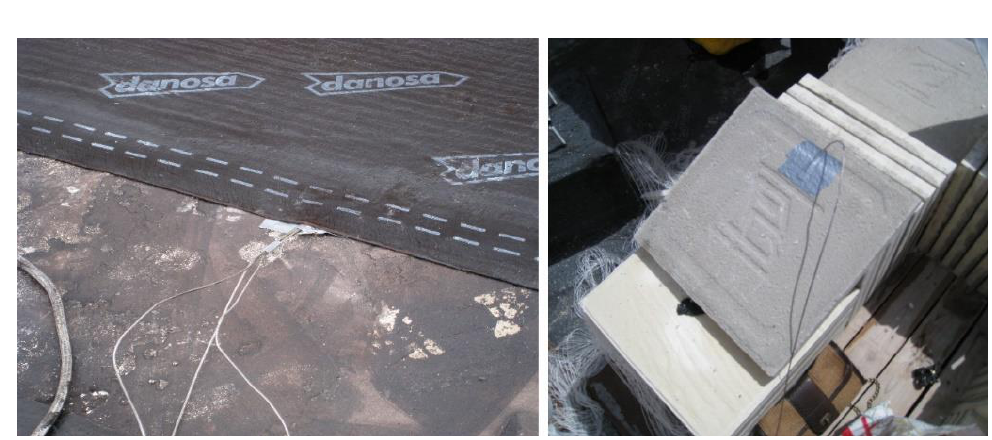
Figure 5. Installation of surface Type K thermocouple sensors on the apartment’s inverted flat roof.